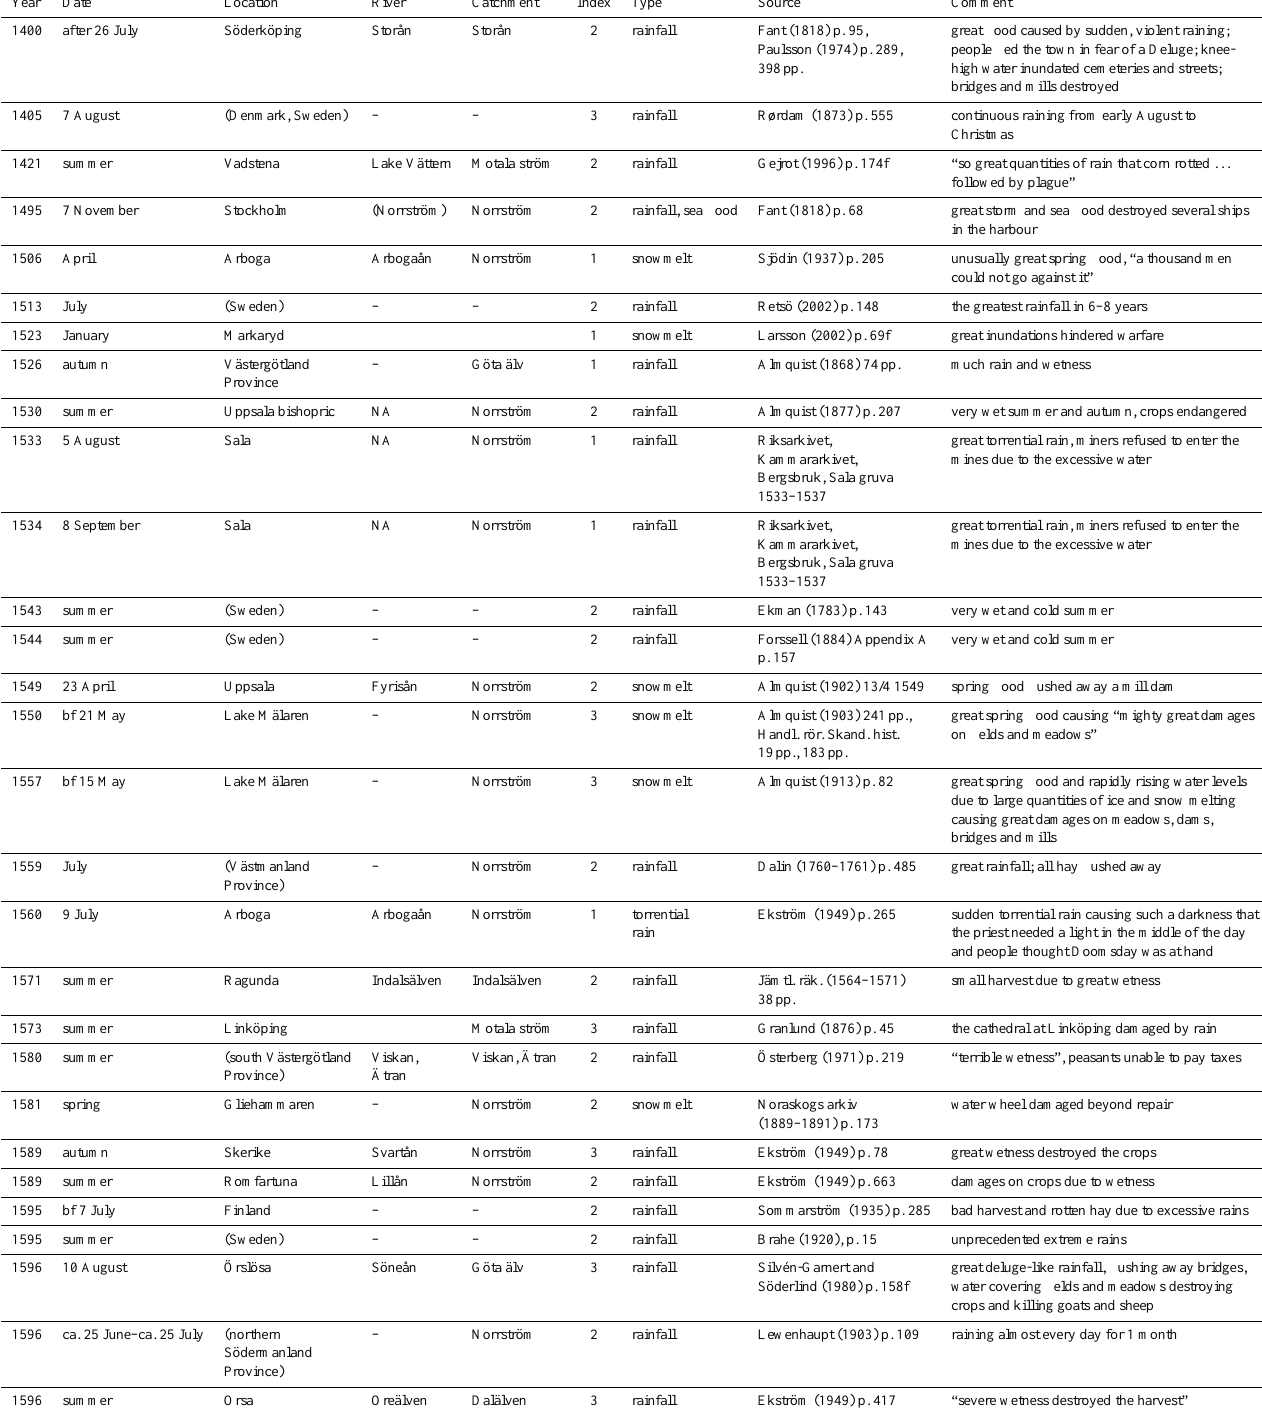
Table A1. Documentary evidence of floods and extreme rainfall events in Sweden 1400–1800 (bf –